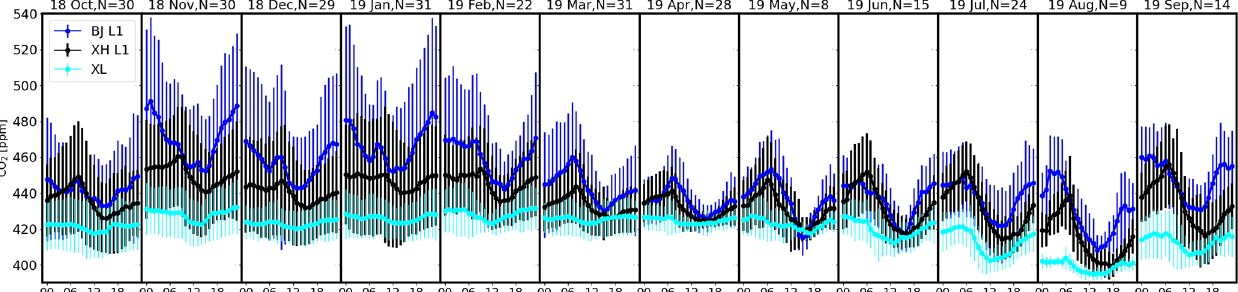
Figure 9. The diurnal cycles of CO 2 variations at BJ L1, XH L1, and XL in each month between October 2018 and September 2019. The collocated days are displayed ( N ). The error bars are the hourly standard deviations of CO 2 .